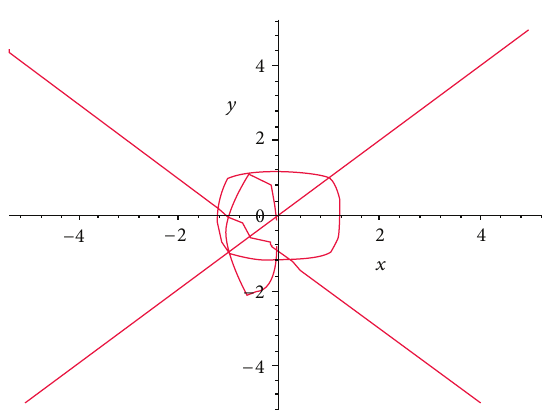
Figure 6: (10, 28, 8/3 , 10).